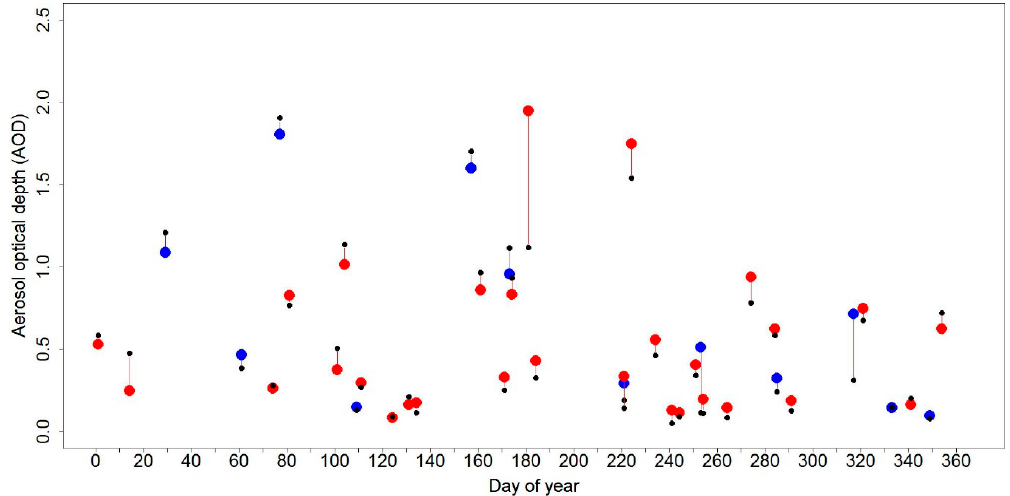
Figure 2. Beijing-CAMS site 2016 results showing the AERONET Level 2.0 AOD (41 small black dots), the Sentinel-2A (29 red filled circles) and the Landsat-8 (12 blue filled circles) AOD values. The vertical lines connect the satellite AOD retrievals with the contemporaneous AERONET AOD measurements (always within 10 minutes of each other). Satellite AOD values are mean non-cloudy values derived from a 1470 m × 1470 m window over the AERONET site. All AOD values are at 550 nm.